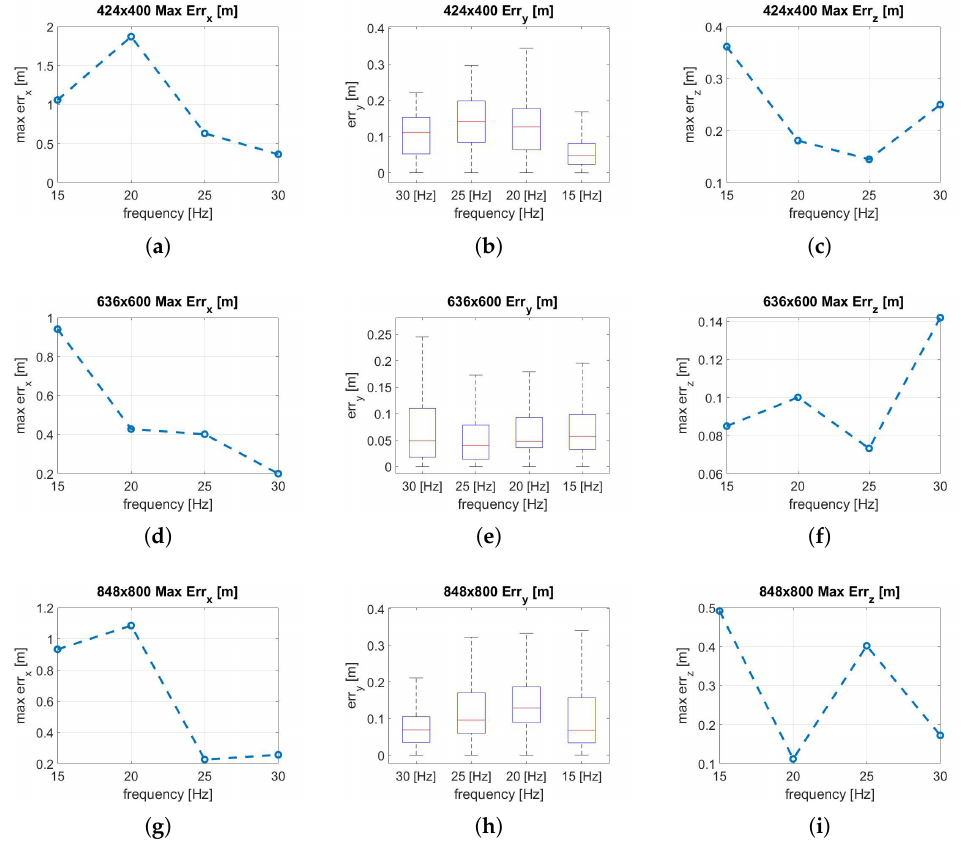
Figure 11. ( a ) X max err, 424 × 400; ( b ) Y err, 424 × 400; ( c ) Z max err, 424 × 400; ( d ) X max err, 636 × 600; ( e ) Y err, 636 × 600; ( f ) Z max err, 636 × 600; ( g ) X max err, 848 × 800; ( h ) Y err, 848 × 800; ( i ) Z max err, 848 × 800. Translation error analysis along the trajectory performed by varying